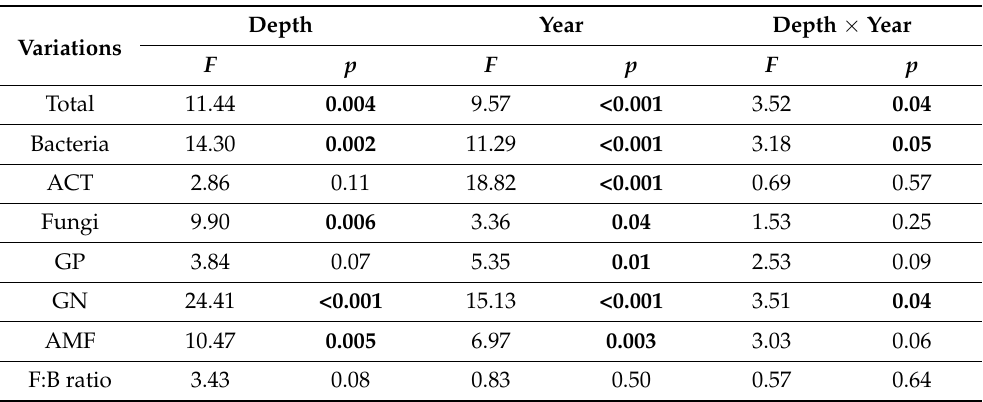
Table 1. Results ( F - and p -values) of two-way ANOVAs on the effects of soil depth (Depth), cropping year (Year), and their interactions on the total, bacteria, actinomycetes (ACT), fungi, Gram-positive bacteria (GP), Gram-negative bacteria (GN), arbuscular mycorrhizal fungi (AMF) PLFAs, and the ratio of fungi to bacteria (F:B ratio). The bold numbers indicate the significance at p ≤